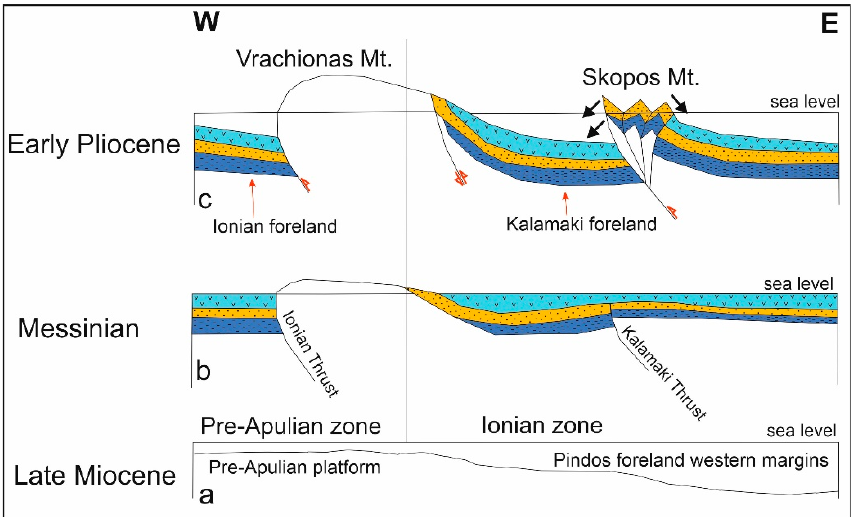
Figure 12. Evolutionary models showing in three stages (Late Miocene, Messinian, and Early Pliocene) the studied area that influenced from the two major thrust faults. ( a ) During Late Miocene, Vrachionas Mountain represents the Apulian Platform Margins, passing gradually eastwards to the Ionian Basin. ( b ) During Messinian, both thrusts were active, producing the Kalamaki and Ionian foreland basins, respectively. ( c ) During Early Pliocene, Kalamaki thrust acted as back-thrust producing on its wedge top three small-restricted sub-basins (Argasi, Mellas, and Xirakastello [10]). Red line in Figure 11 shows the position of cross-sections.